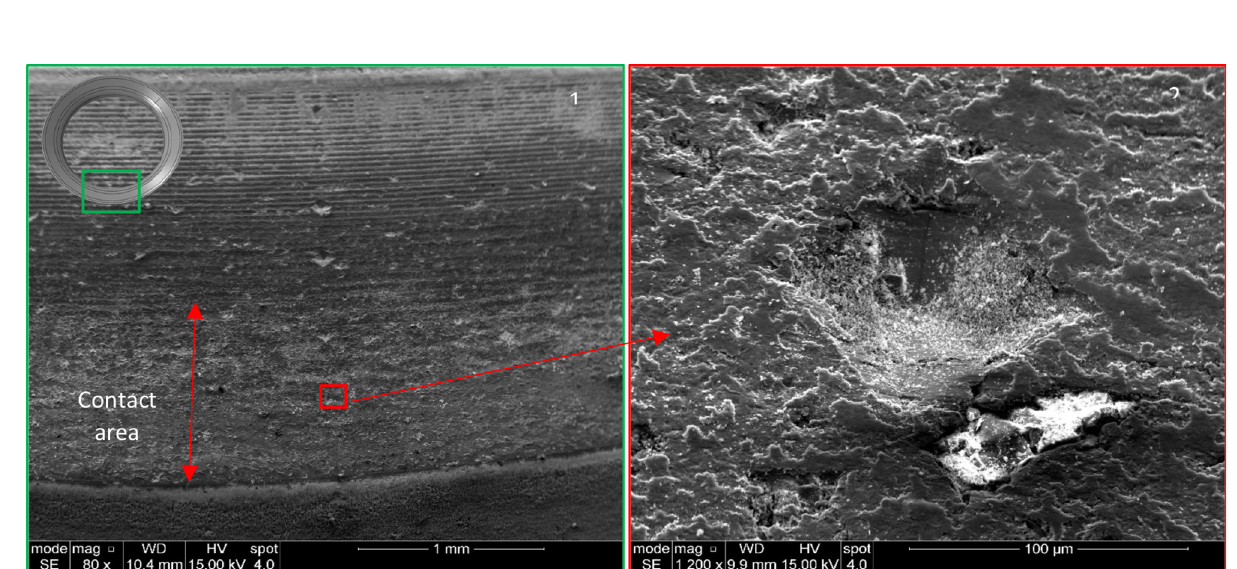
Fig. 26. Intake seat after 4 hours of operation on the “ Cube ” , without exhaust gas but with fresh air intake, heating to 250 ° C, 18,750N and impact speed of 650 mm/s, (1) General view of the contact, (2) Magni fi cation in the effective contact